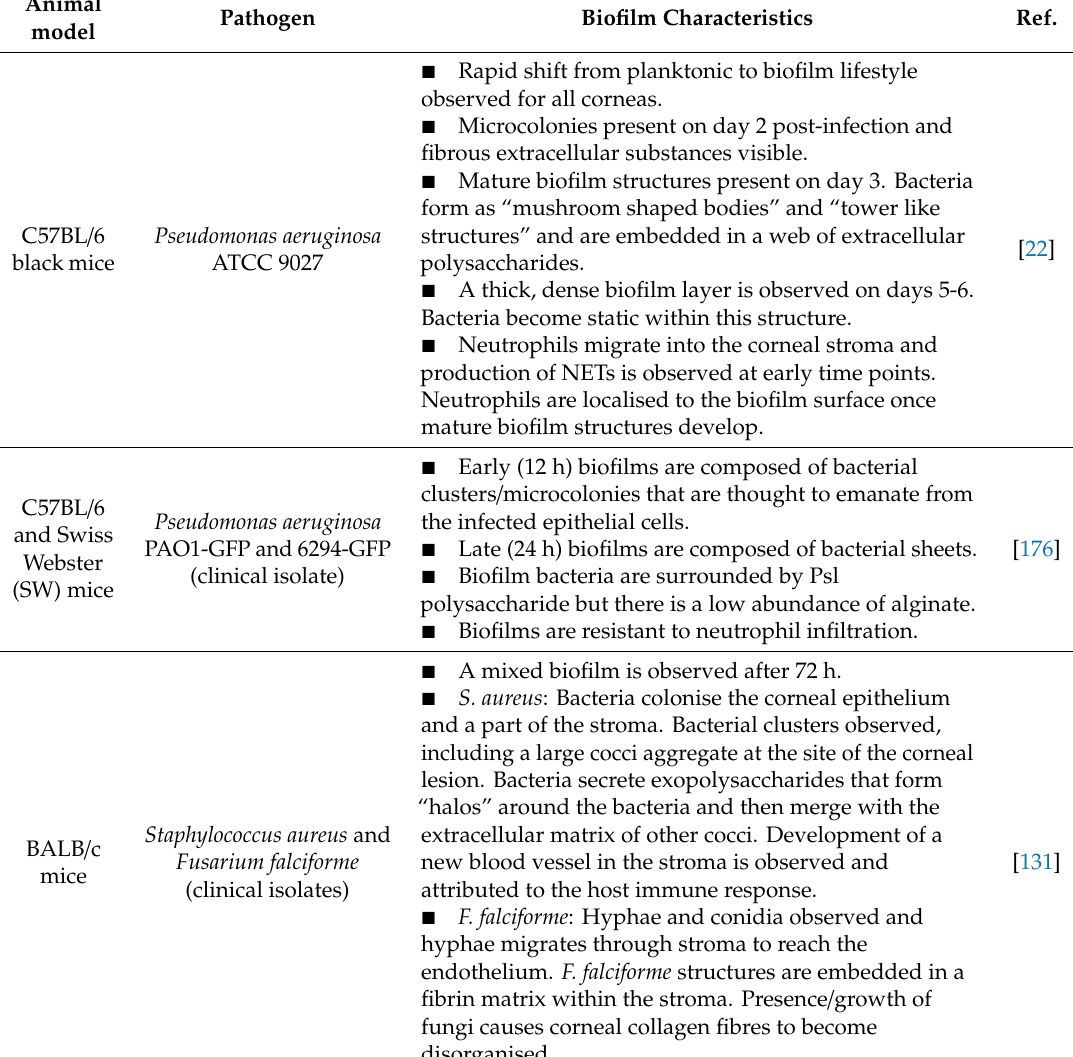
Table 2. Biofilm characteristics of in vivo corneal infection